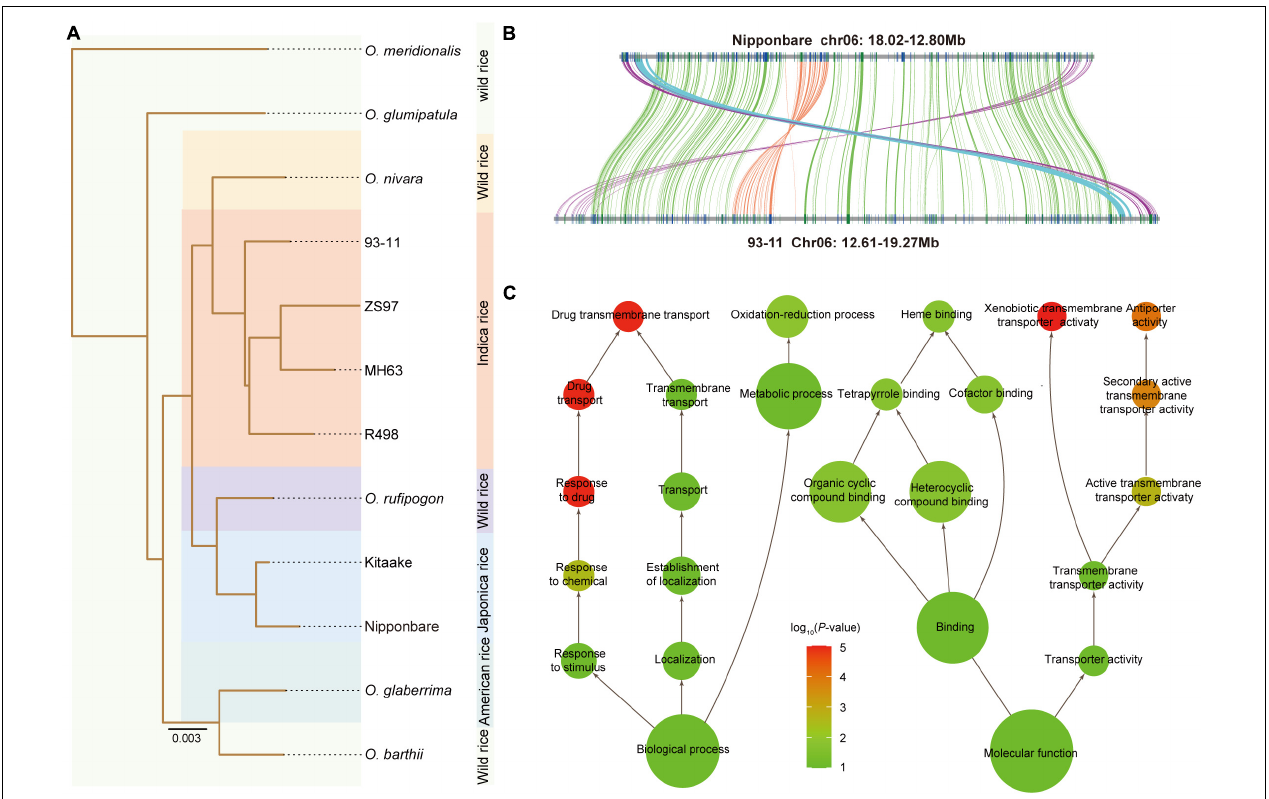
FIGURE 3 | Chromosome inversion events. (A) Phylogenic tree of cultivars and wild species of Oryza . (B) Collinearity between 93-11 and Nipponbare shows the presence of a paracentric inversion (orange lines) within the pericentric inversion (green lines). Additionally, another paracentric inversion (cyan lines) next to the pericentric inversion was also identified. (C) Functional enrichment of the genes in the inversion region. The color scale indicates the P -value, and the size of the circle indicates the number of genes.